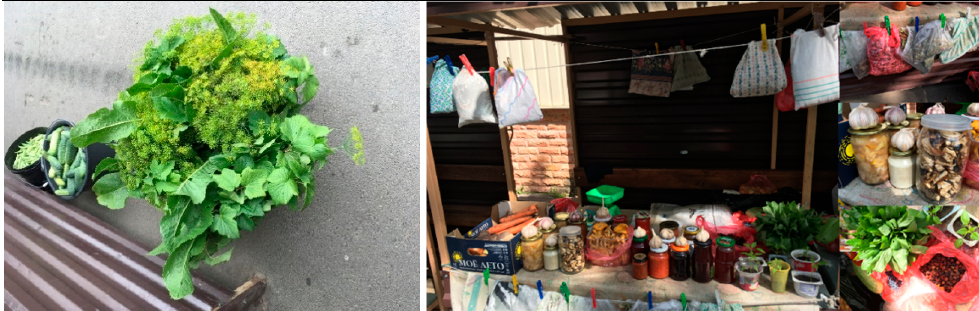
Figure 9. Pechory market. Left: Set of herbs for cucumber lacto-fermentation: Armoracia rusticana leaves, Anethum graveolens stalks with seeds, and Ribes nigrum leaves. July 2018. Right: homemade preserves made from mushrooms and wild and cultivated plants. August 2019. Photos by Olga Belichenko.